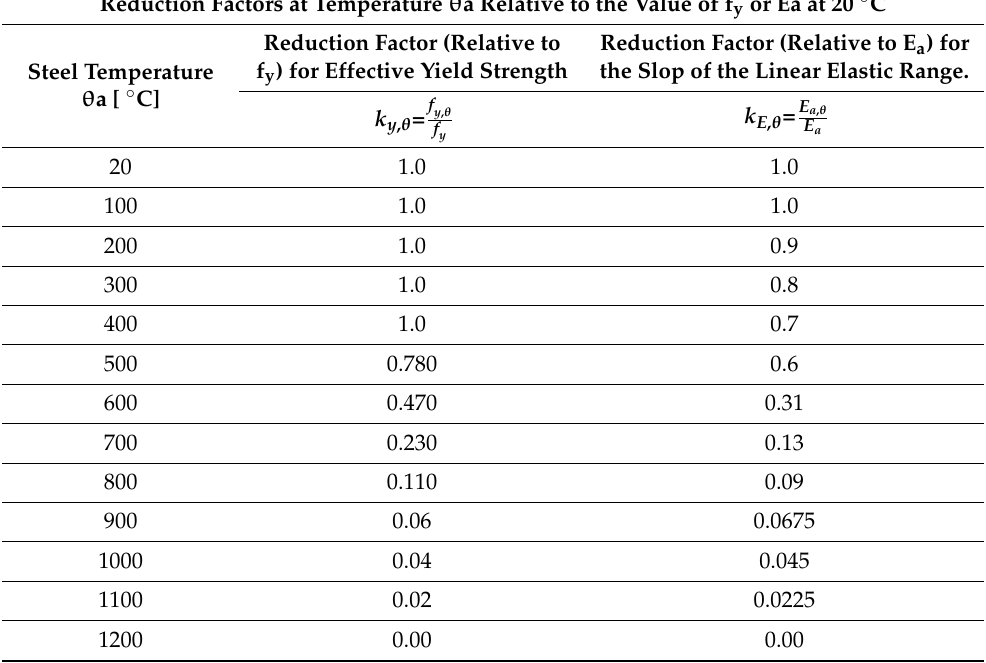
Table 1. Reduction factors for carbon steel at elevated temperatures